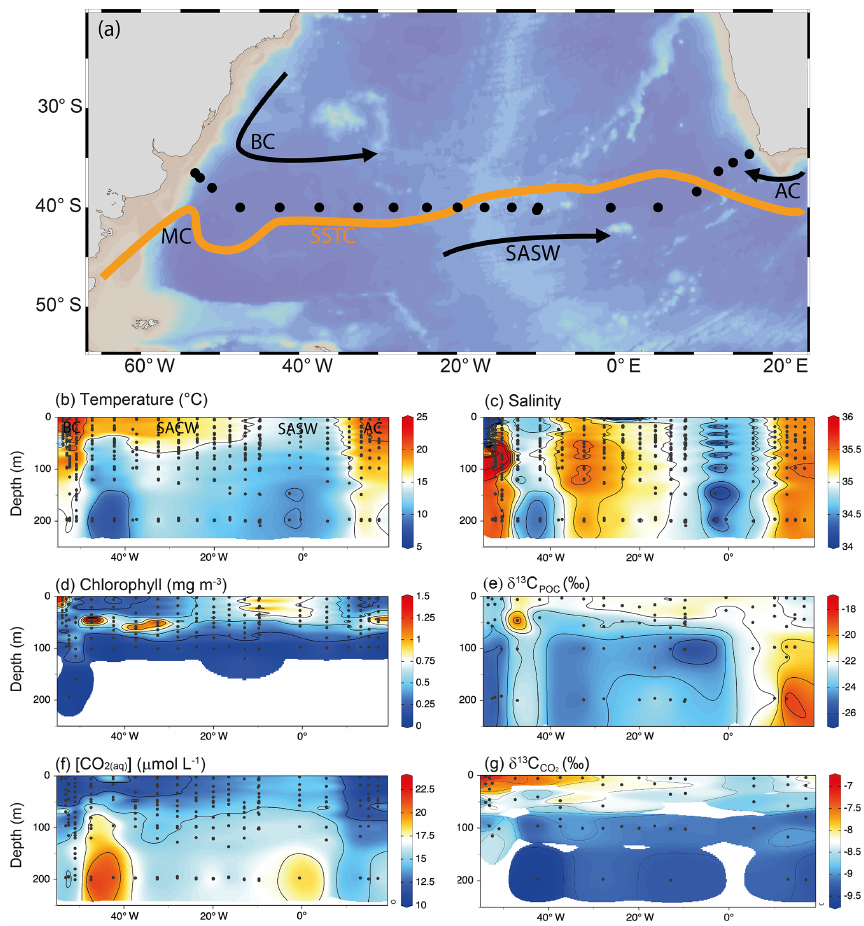
Figure 1. Map and longitudinal transects across the south subtropical convergence. (a) Map of the study region, in which the orange line de- picts the subtropical front (SST = 16 ◦ C, from Browning et al., 2014). Longitudinal transects of (b) temperature, (c) salinity, (d) chlorophyll, (e) δ 13 C POC , (f) [CO 2 ( aq ) ] and (g) δ 13 C CO in the upper 250m. The water masses are identified in (b) : BC refers to the Brazil Current, 2 SACW refers to the South Atlantic Central Water, SASW refers to the Subantarctic Surface Water and AC refers to the Agulhas Current. The interpolation in (b) – (g) was produced using ODV-weighted average gridding (Schlitzer,